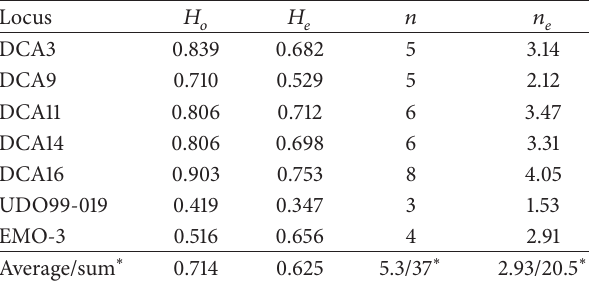
Table 1: Parameters of genetic variability of each microsatellites locus obtained among offspring population (embryos). Observed ( 𝐻 𝑜 ) and expected ( 𝐻 𝑒 ) heterozygosity, number of alleles ( 𝑛 ), and effective number of alleles ( 𝑛 𝑒